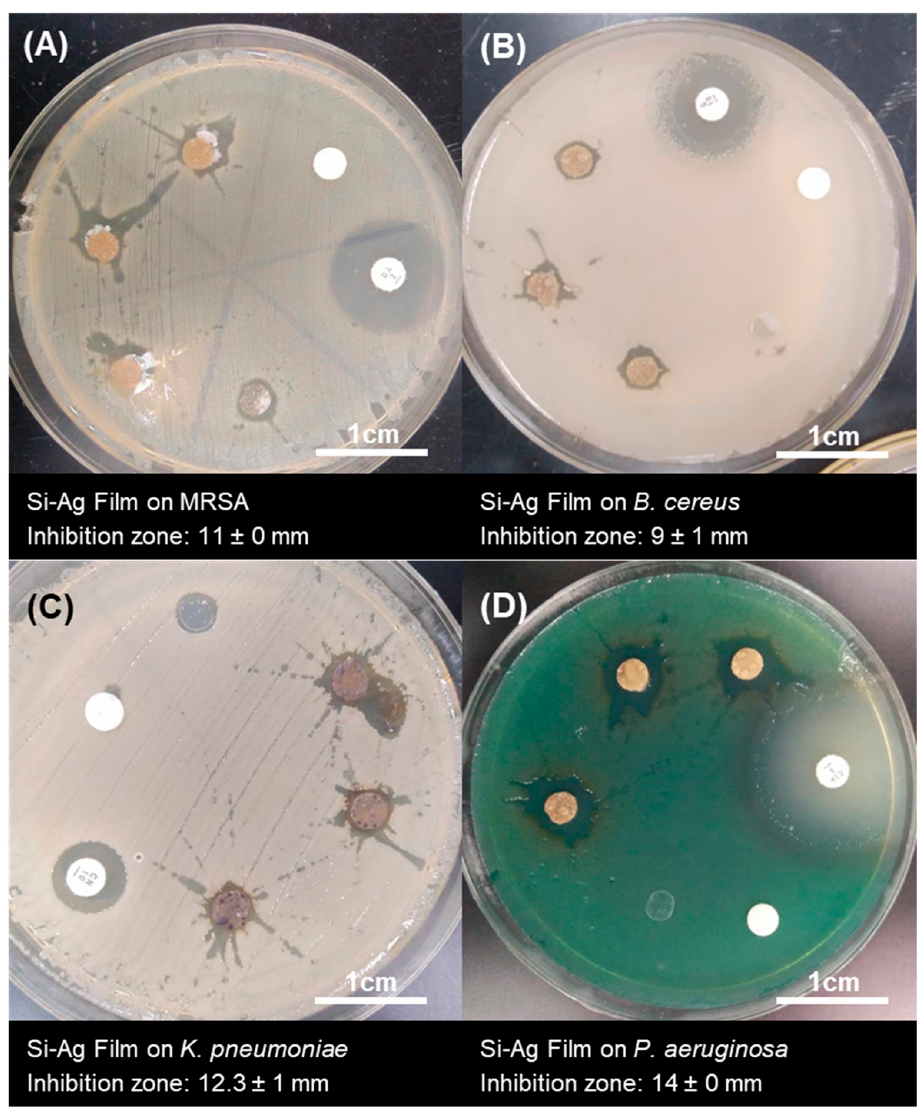
Figure 8. The inhibition zone of Si–Ag thin films against Gram-positive bacteria, ( A ) MRSA and ( B ) B. cereus , and Gram-negative bacteria, ( C ) K. pneumoniae and ( D ) P. aeruginosa , as evaluated with the Kirby–Bauer disk diffusion method. Measurements were performed in triplicate.